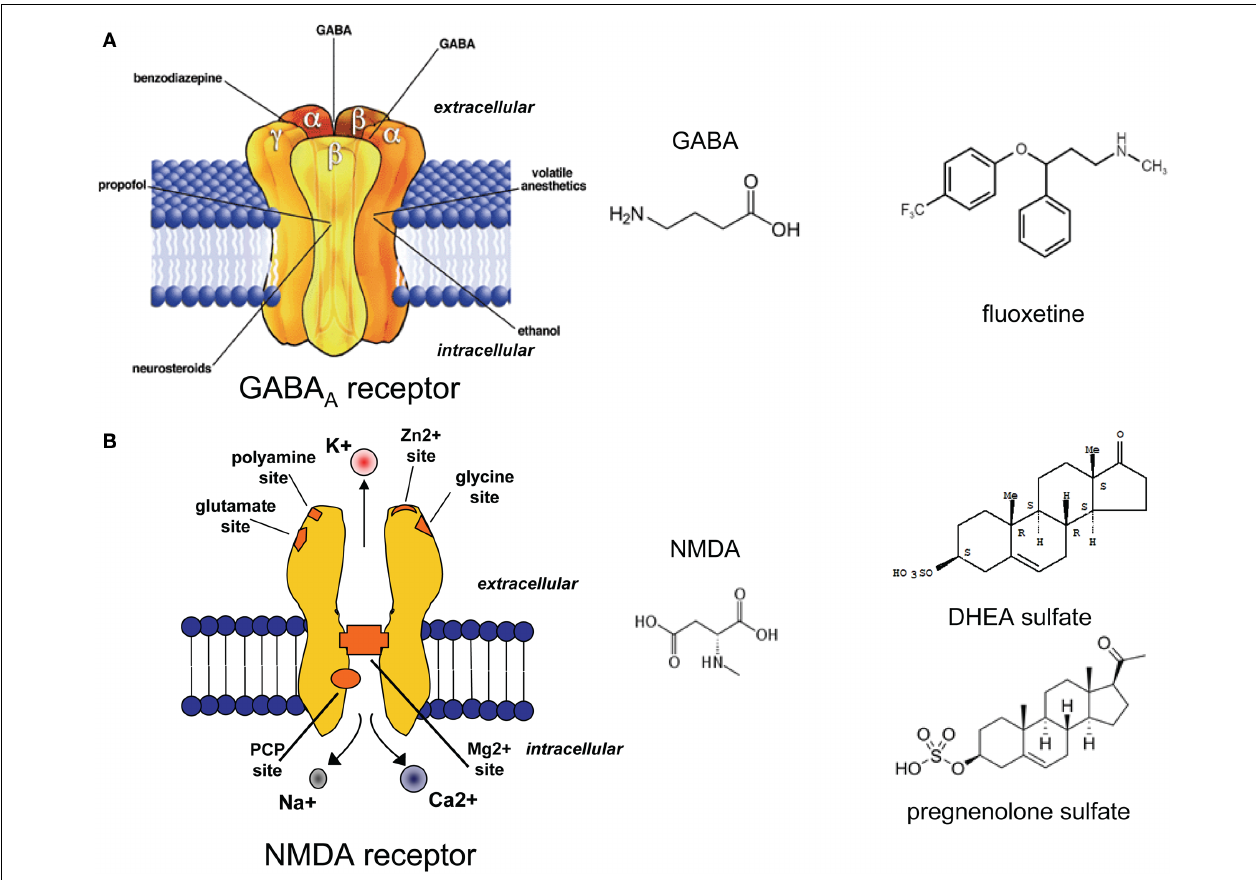
fluoxetine. Fluoxetine has been shown to increase the brain and cerebrospinal fluid content of 3 α , 5 α THP, a potent positive allosteric GABA A receptor